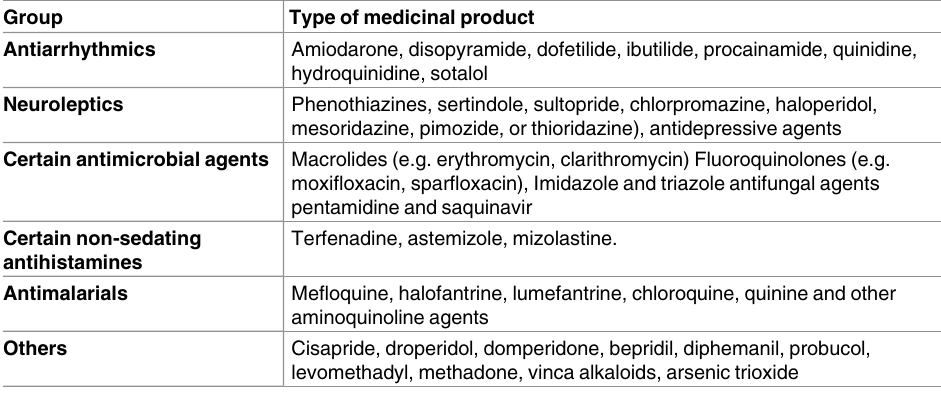
Table 1. Products that are known to prolong the QTc